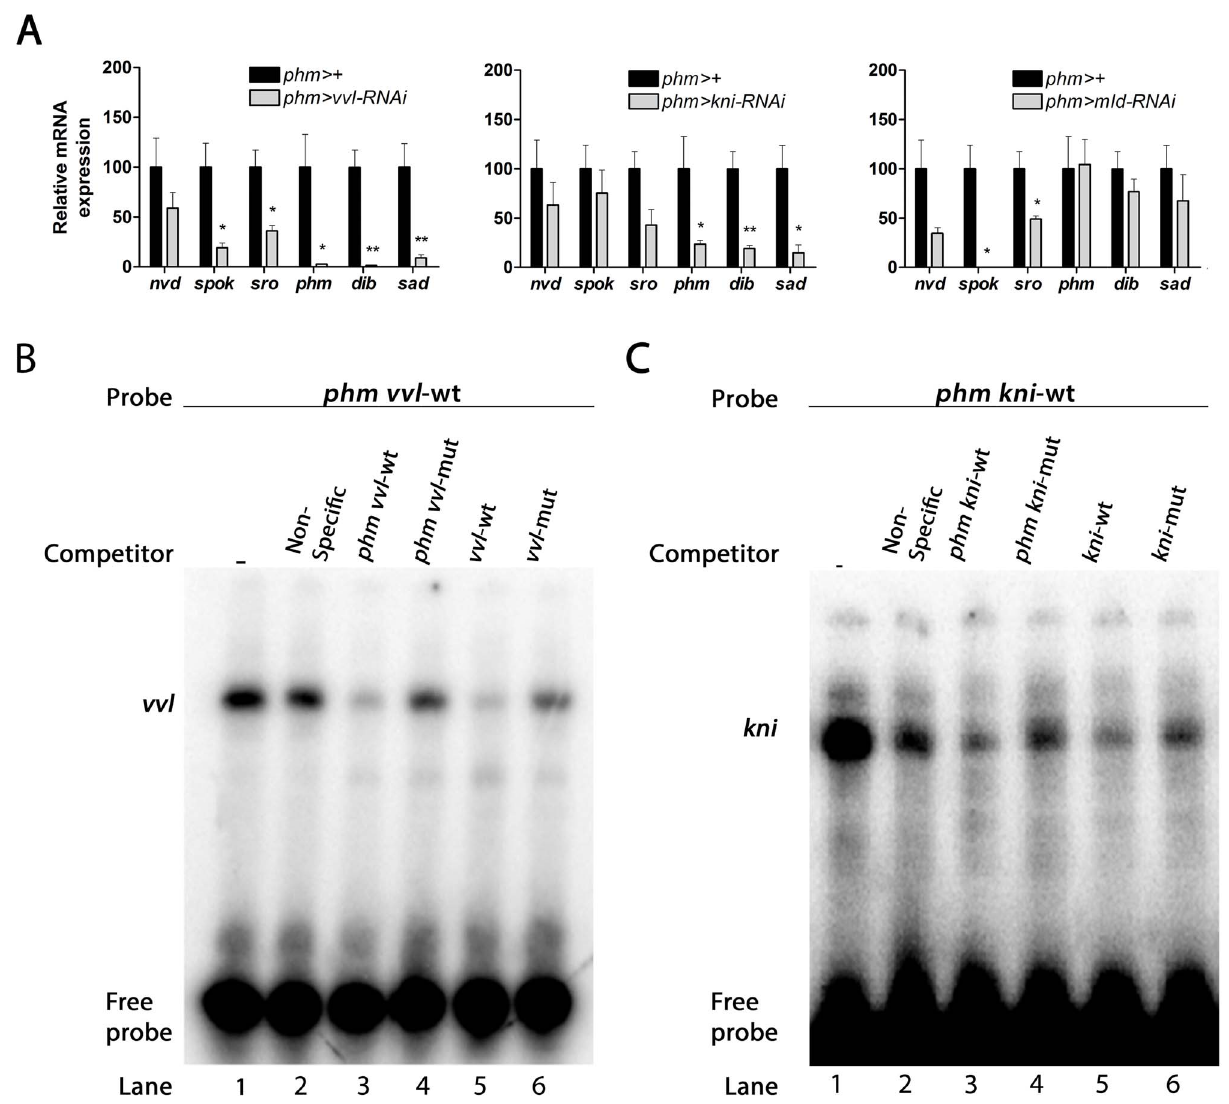
Figure 3. vvl , kni and mld are required for the expression of genes in the ecdysone biosynthetic pathway. (A) Knock down of vvl , kni and mld in the PG reduces expression of genes in the steroidogenic pathway. vvl knock down results in a down-regulation of spok and sro , catalyzing early steps in the pathway, as well as a reduction of phm , dib and sad mediating the last three steps in the biosynthetic pathway. Knock down of kni results in down-regulation of phm , dib and sad , while knock down of mld causes a specific down-regulation of spok and a moderate reduction of sro . Expression was measured in mid-first instar larvae 36 hours AEL. Error bars indicate s.e.m. (n=4). * P , 0.05, ** P , 0.01, versus the phm . + control. (B, C) Direct binding of Vvl or Kni to the regulatory sites in phm promoter indicated by electrophoretic mobility shift assay (EMSA). Nuclear extract was incubated with [ c 32]ATP-labeled oligonucleotide sequences of phm promoter containing the vvl (B) or the kni sites (C) and resulted in shifted DNA- protein bands (lane 1). Competition assays were performed with unlabeled non-specific random oligonucleotide sequences (lane 2), the phm promoter containing the vvl or kni sites (lane 3), the phm promoter with mutated vvl or kni sites (lane 4), an oligonucleotide sequence with vvl or kni consensus motif sequence (lane 5), or with the consensus motif mutated (lane